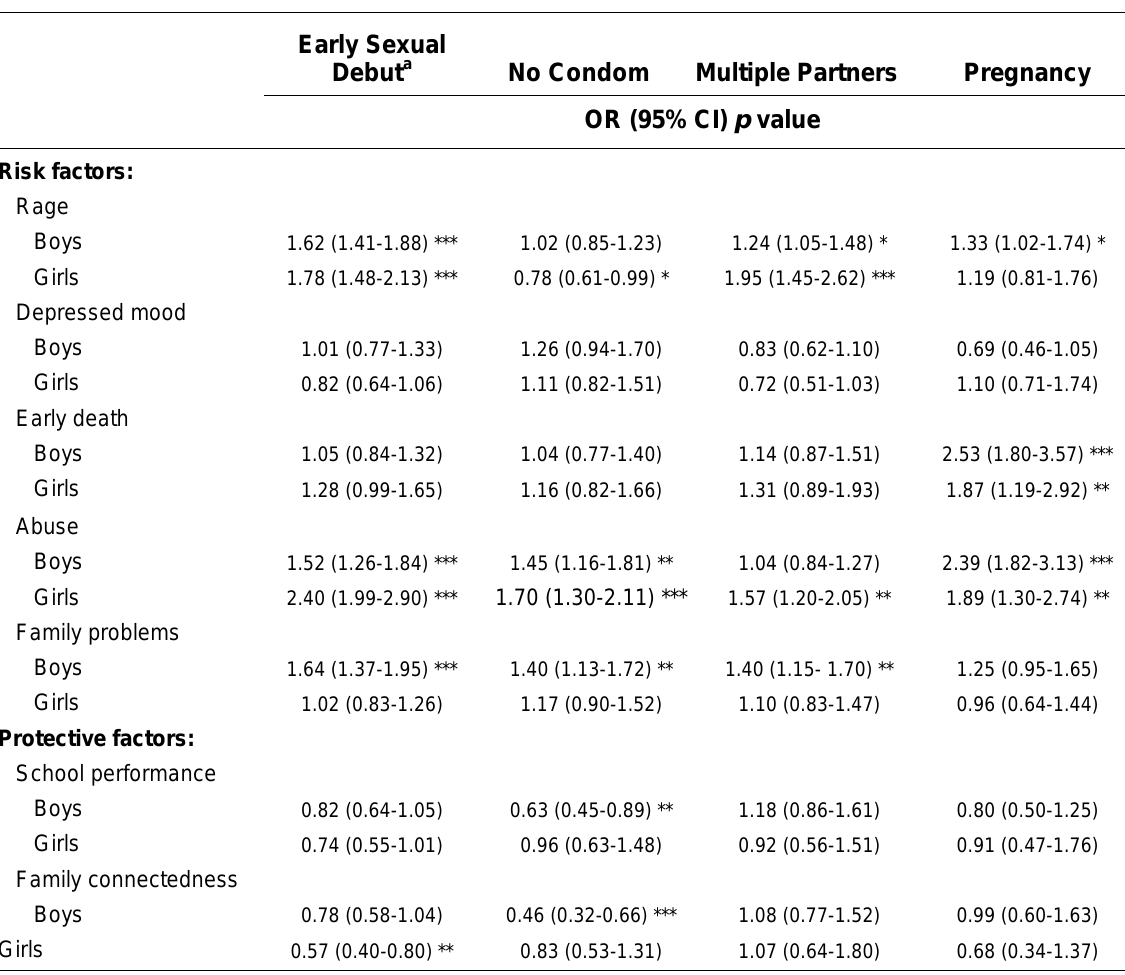
Multivariate Analysis of Risk and Protective Factors for High-Risk Sexual Behaviors in Caribbean Youth Reporting Sexual Activity, Controlled for Age (n =